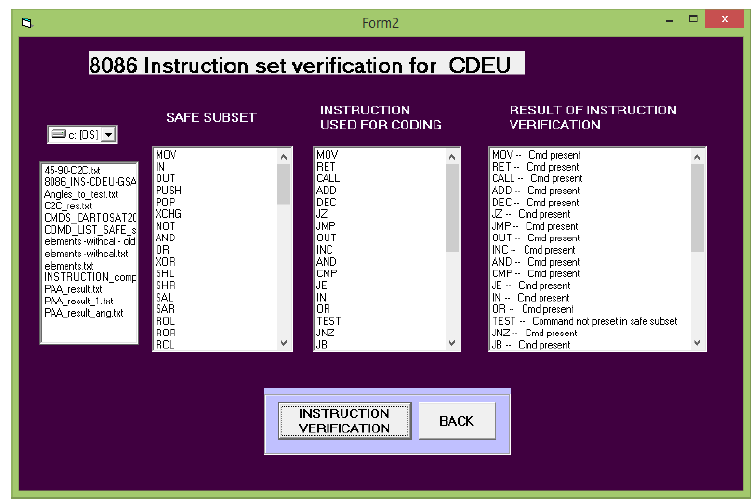
Figure 3. Validating the CDEU instructions against the safe subset